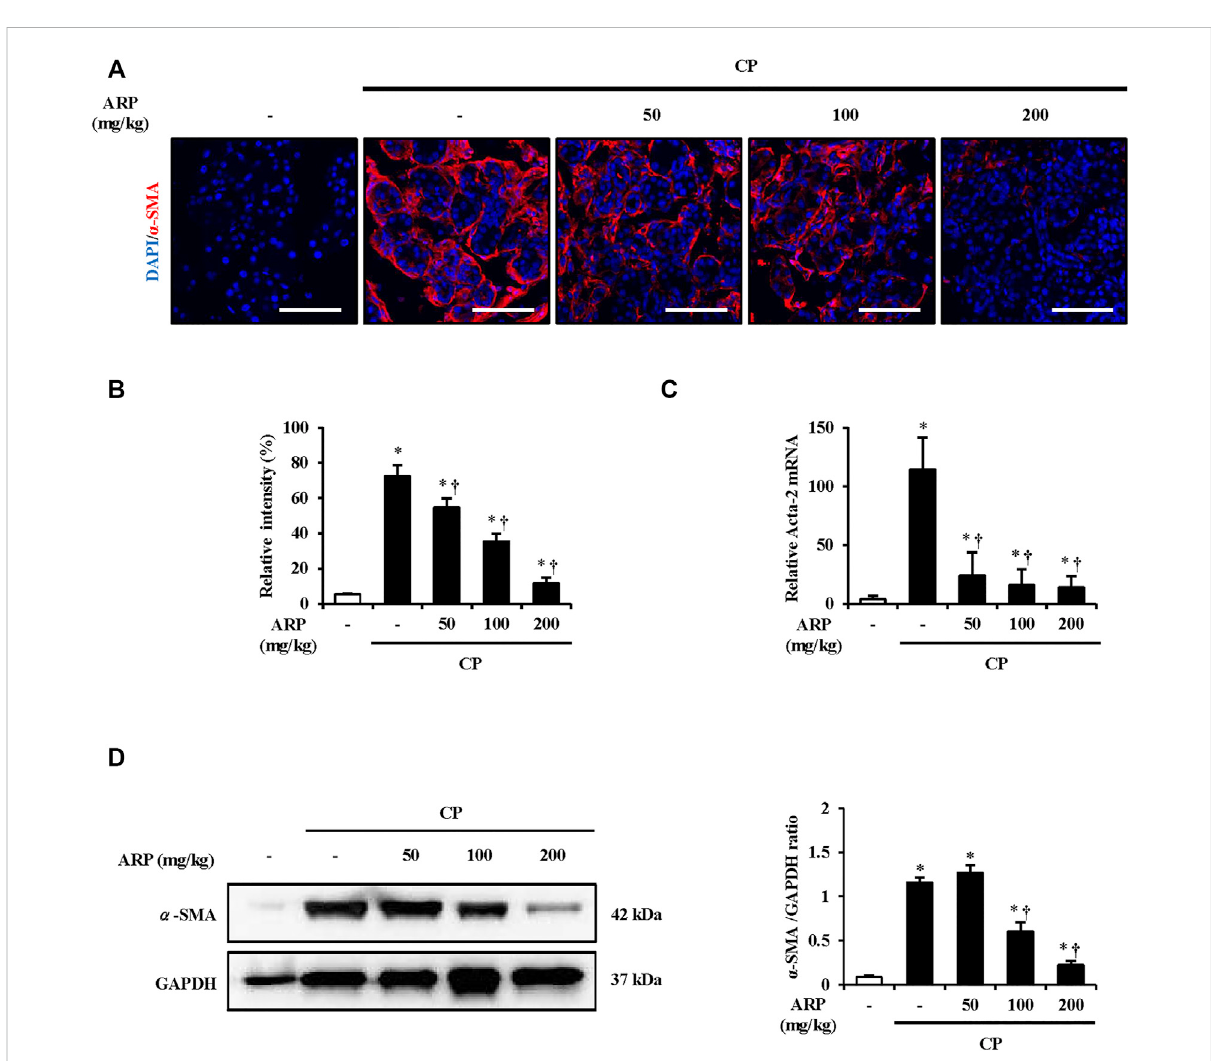
EffectofARPwaterextractonPSCactivation. (A) Confocalimagesofimmuno fl uorescencestainingfor α -SMAinthesaline,CP,andARPgroups (50, 100, and 200 mg/kg); the red color shows α -SMA positive cells, and the blue color shows DAPI positive cells. (B) The relative intensity of α -SMA. (C) Acta-2 mRNA level in the pancreas was assessed using RT-qPCR. (D) Protein expression of α -SMA was assess using western blot analysis and GAPDH was used as a loading control. Data are represented as means ± SEM ( n = 3 per group). Results are representative of three